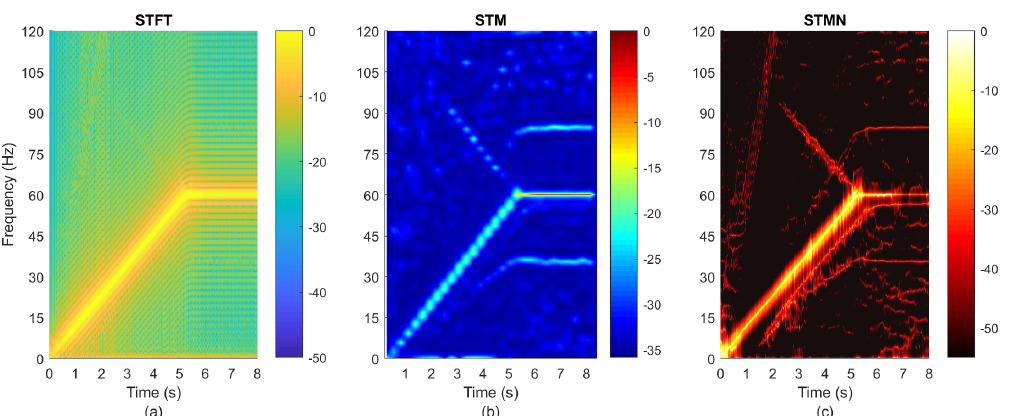
Figure 7. ( t , f ) analysis of the starting current with the ASD-fed induction motor driving a rated load, for the case of rotor fault. Time-frequency analysis by: ( a ) Short-Time Fourier Transform. ( b ) Short-Time MUSIC. ( c ) Short-Time Minimum